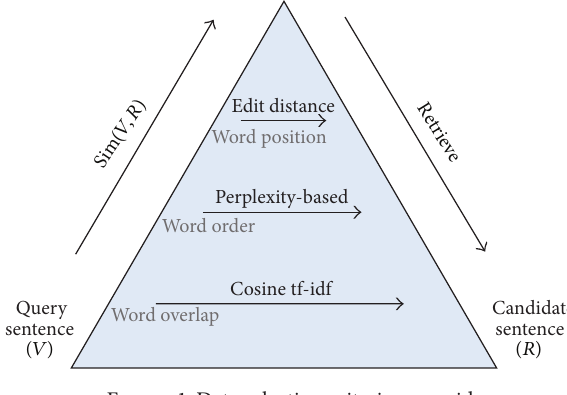
Figure 1: Data selection criteria